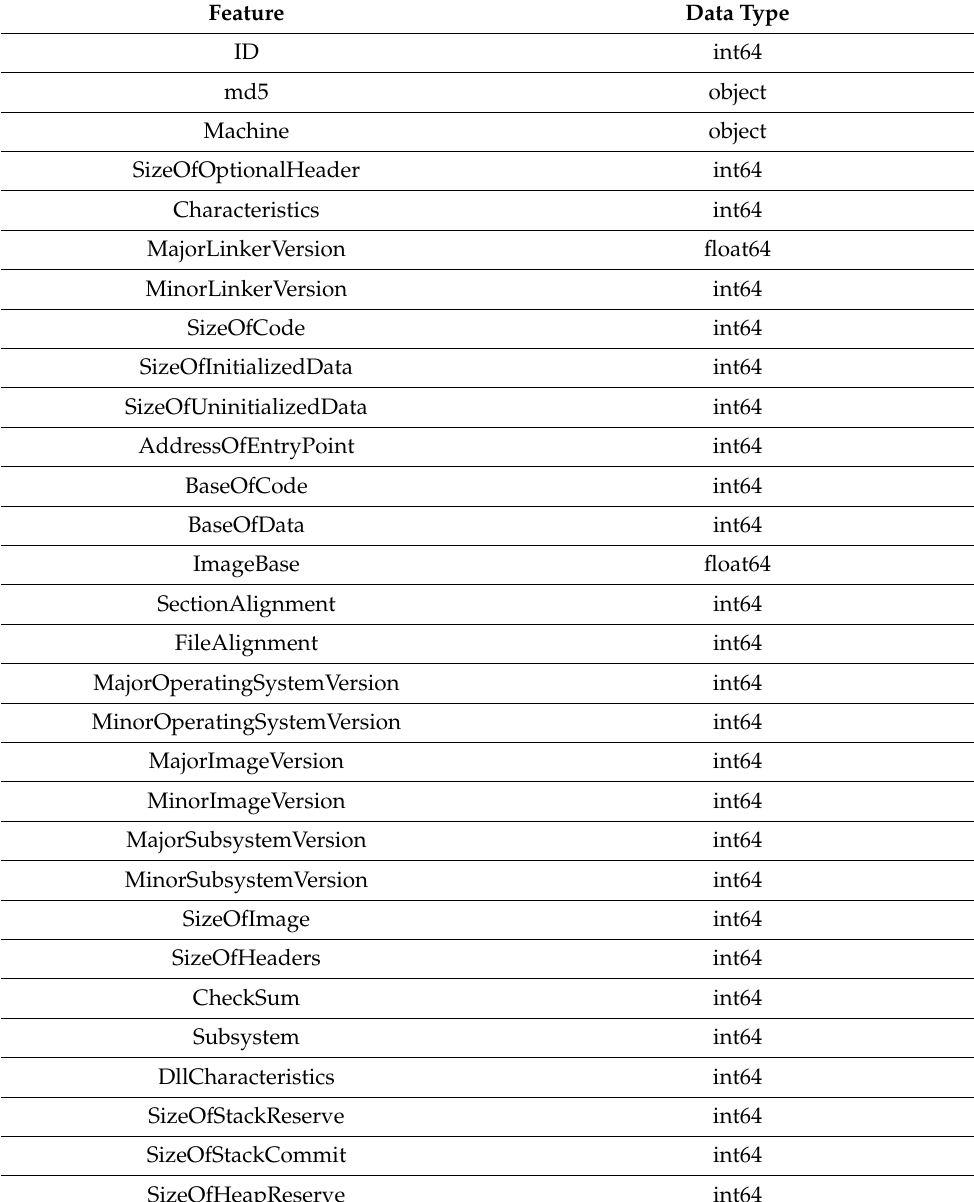
Table A1. Initial dataset features and their data